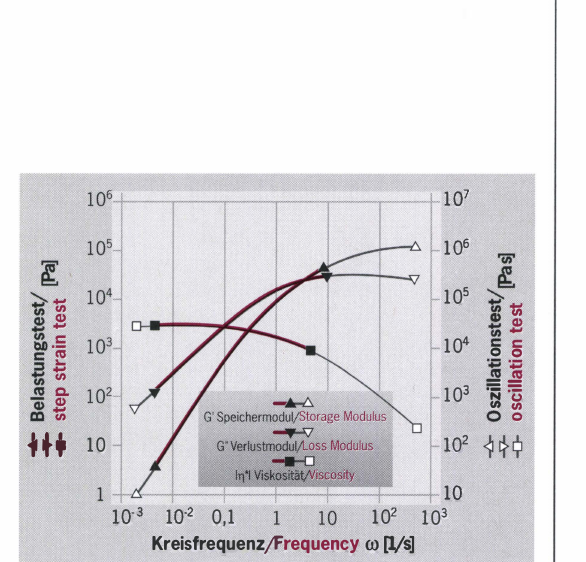
Fig.4: Comparison of the storage modulus G' and loss modulus G" from the step strain experiment (compare Fig. 3, calculated from the relaxation modulus G(t) over the continuous relaxation time spectrum) with that from the frequency